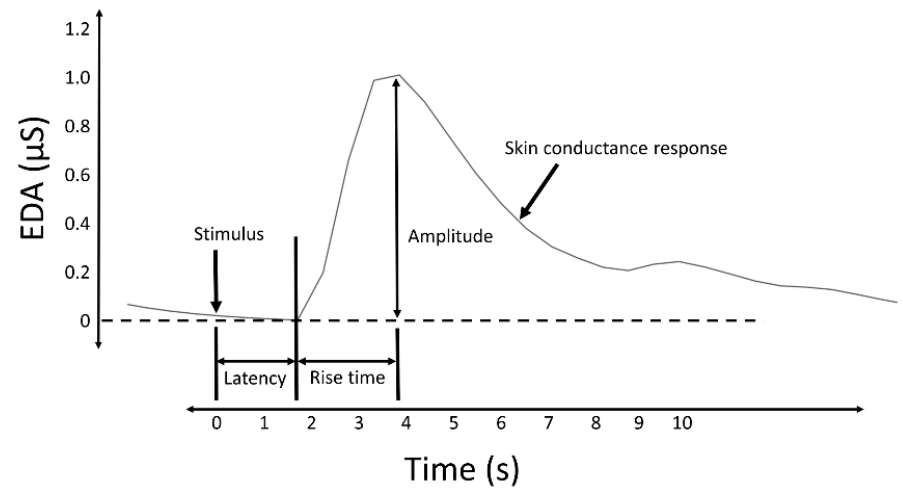
Figure 2. A typical skin conductance response (SCR) and illustration of some derived measures.